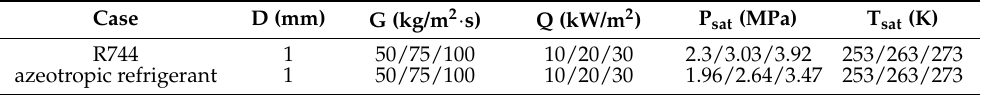
Table 1. Simulation conditions.